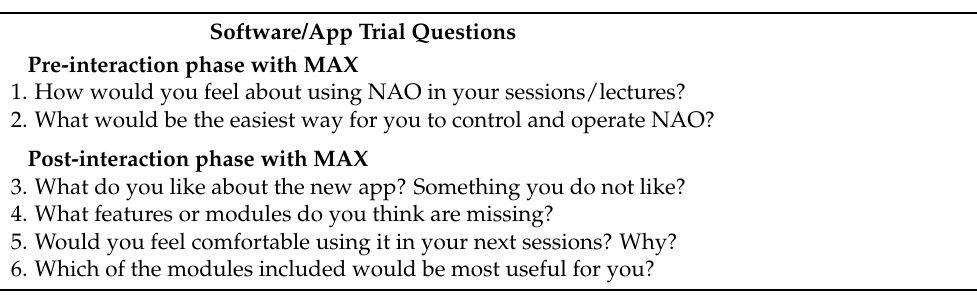
Table 3. Subset of MAX trial focus group